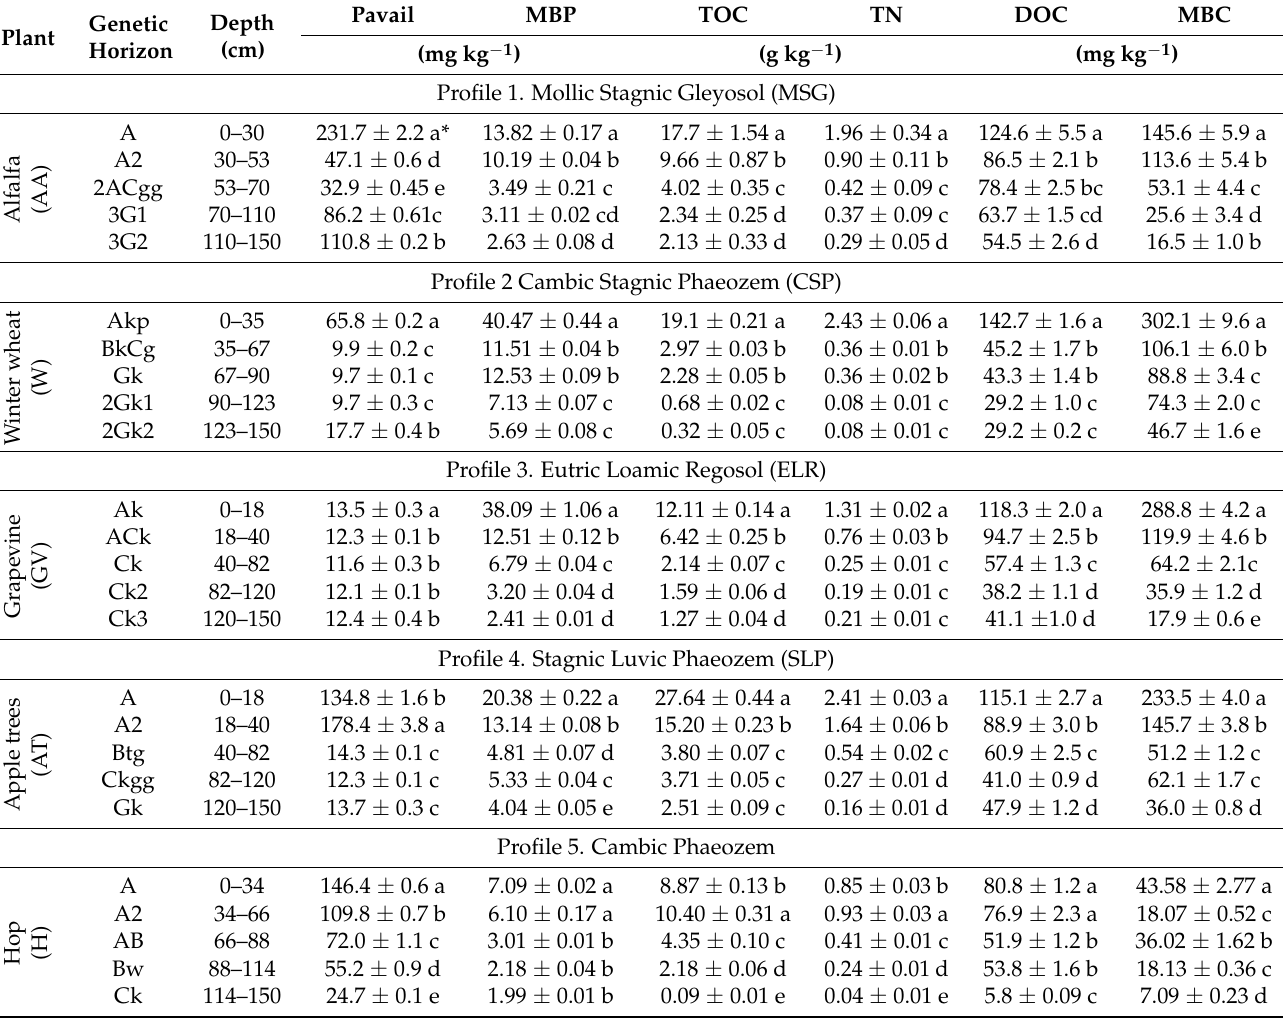
Table 2. Depth distribution of soil phosphorus, carbon and nitrogen, mean (SE), n =